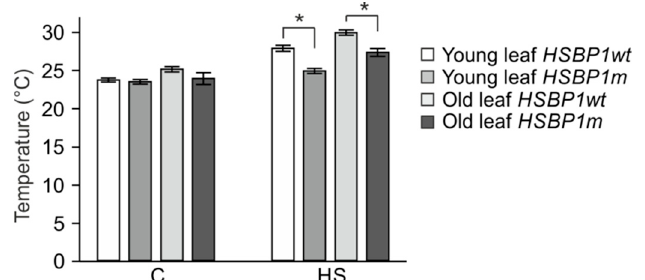
Figure 7. E ff ect of SlHSBP1 mutation on leaf surface temperature. Young and old leaf temperature of SlHSBP1wt and SlHSBP1m plants after a gradual exposure to HS that reached 36 ◦ C at maximum or were kept at 25 ◦ C for the same period as the control (sample C). Values are the average of eight plants from a representative experiment. Asterisks denote significant di ff erences ( p < 0.05) based on t-test